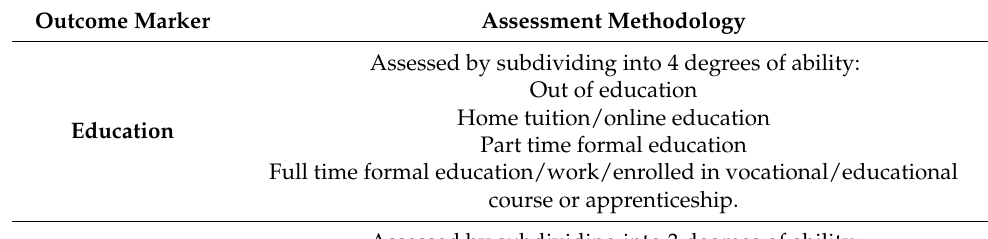
Table 2. Outcome markers